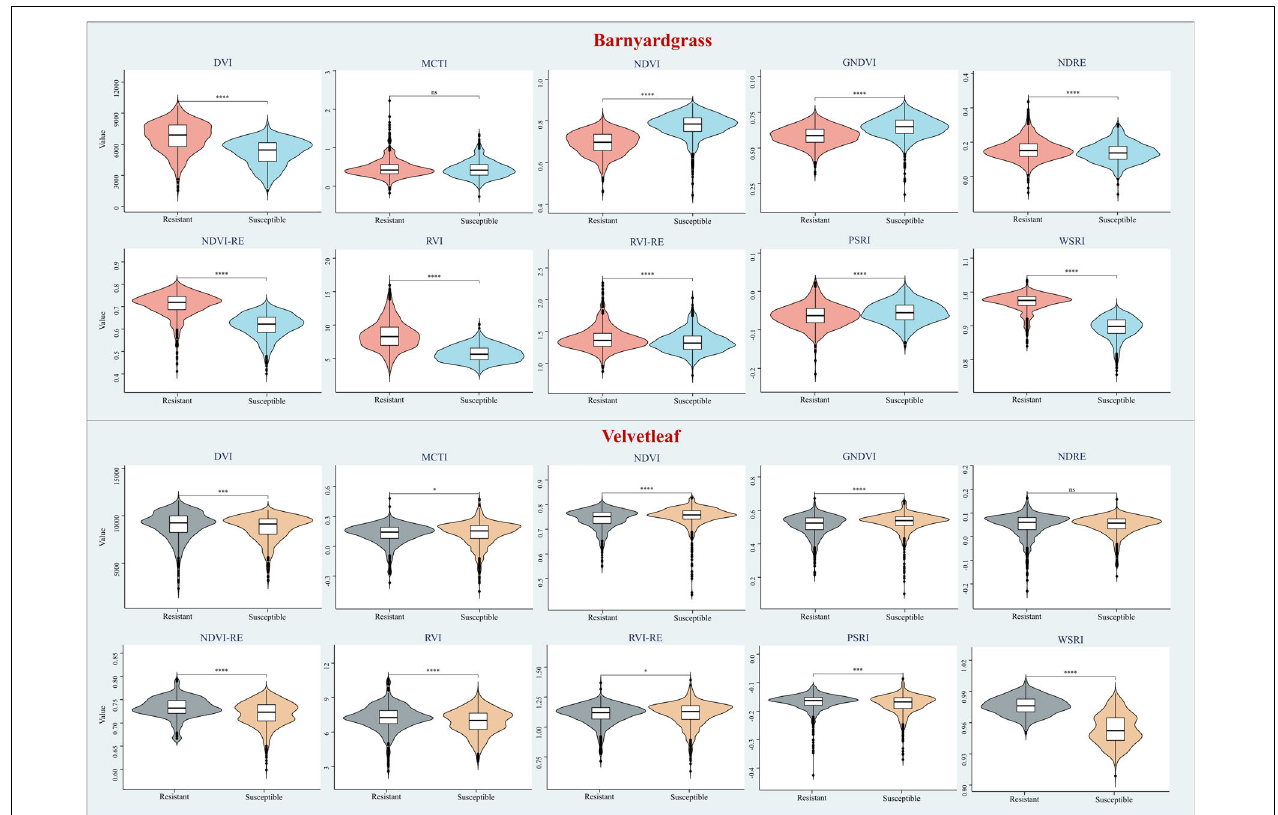
FIGURE 5 | Violin plots of different vegetation indices for susceptible and resistant biotypes of barnyardgrass and velvetleaf 2 days after application, where * p < 0.05; ** p < 0.01; *** p < 0.001; and **** p < 0.0001 indicate significant differences between the susceptible and resistant biotypes, and ns indicates no significance